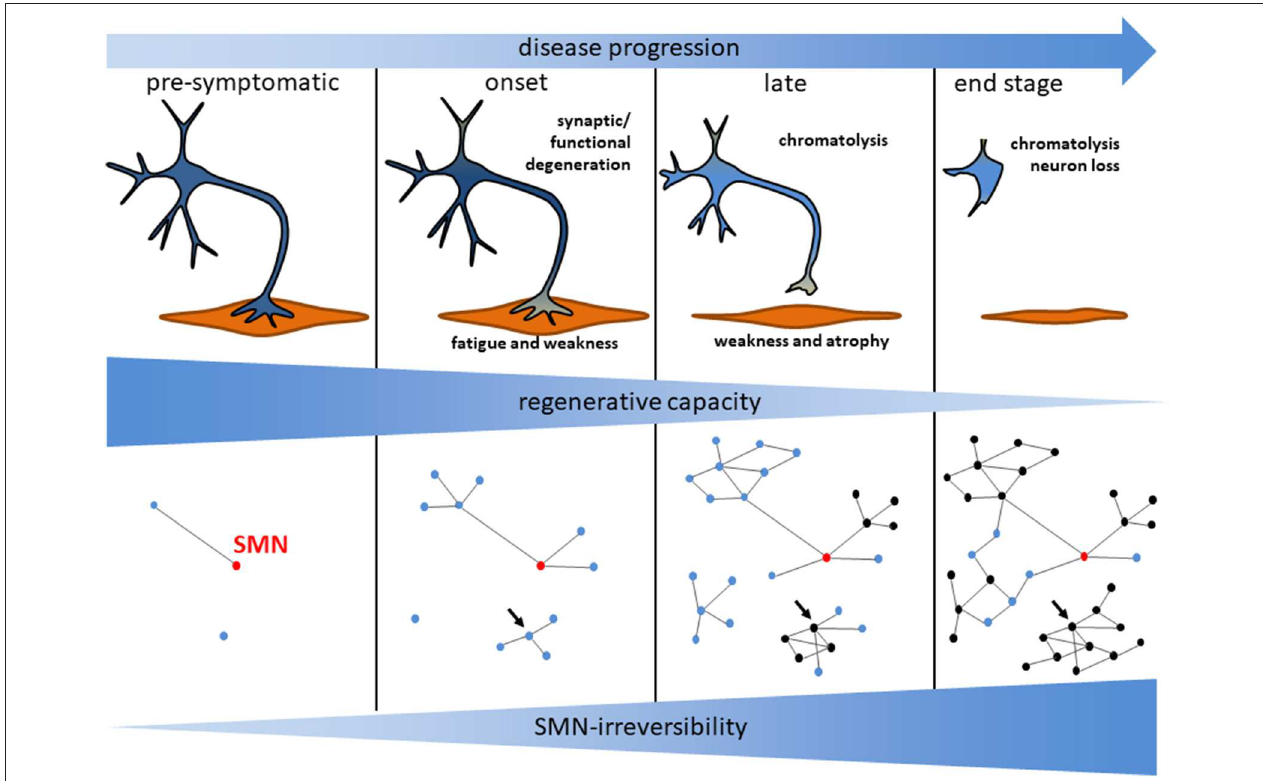
FIGURE 1 | Model for motoneuron degeneration and the underlying signaling network in SMA. Motoneuron loss observed in post mortem analyses is preceded by a functional degeneration of central synapses and the neuromuscular junction. The subsequent axonal damage induces a chromatolytic phenotype of the motoneurons. During disease progression those processes become less reversible indicated by a reduced regenerative capacity. This is reflected by a growing network of dysregulated signaling nodes with an increased fraction of SMN-irreversible (black) vs. SMN-reversible (blue) signaling mediators. SMN-restoration restores blue nodes only. The relative number of SMN-restorable nodes becomes reduced over time as illustrated in this hypothetical scheme. Highly connected SMN-irreversible (black) nodes may be potent treatment targets (arrow). Those nodes may be critical regulators for a module involved in a specific degenerative